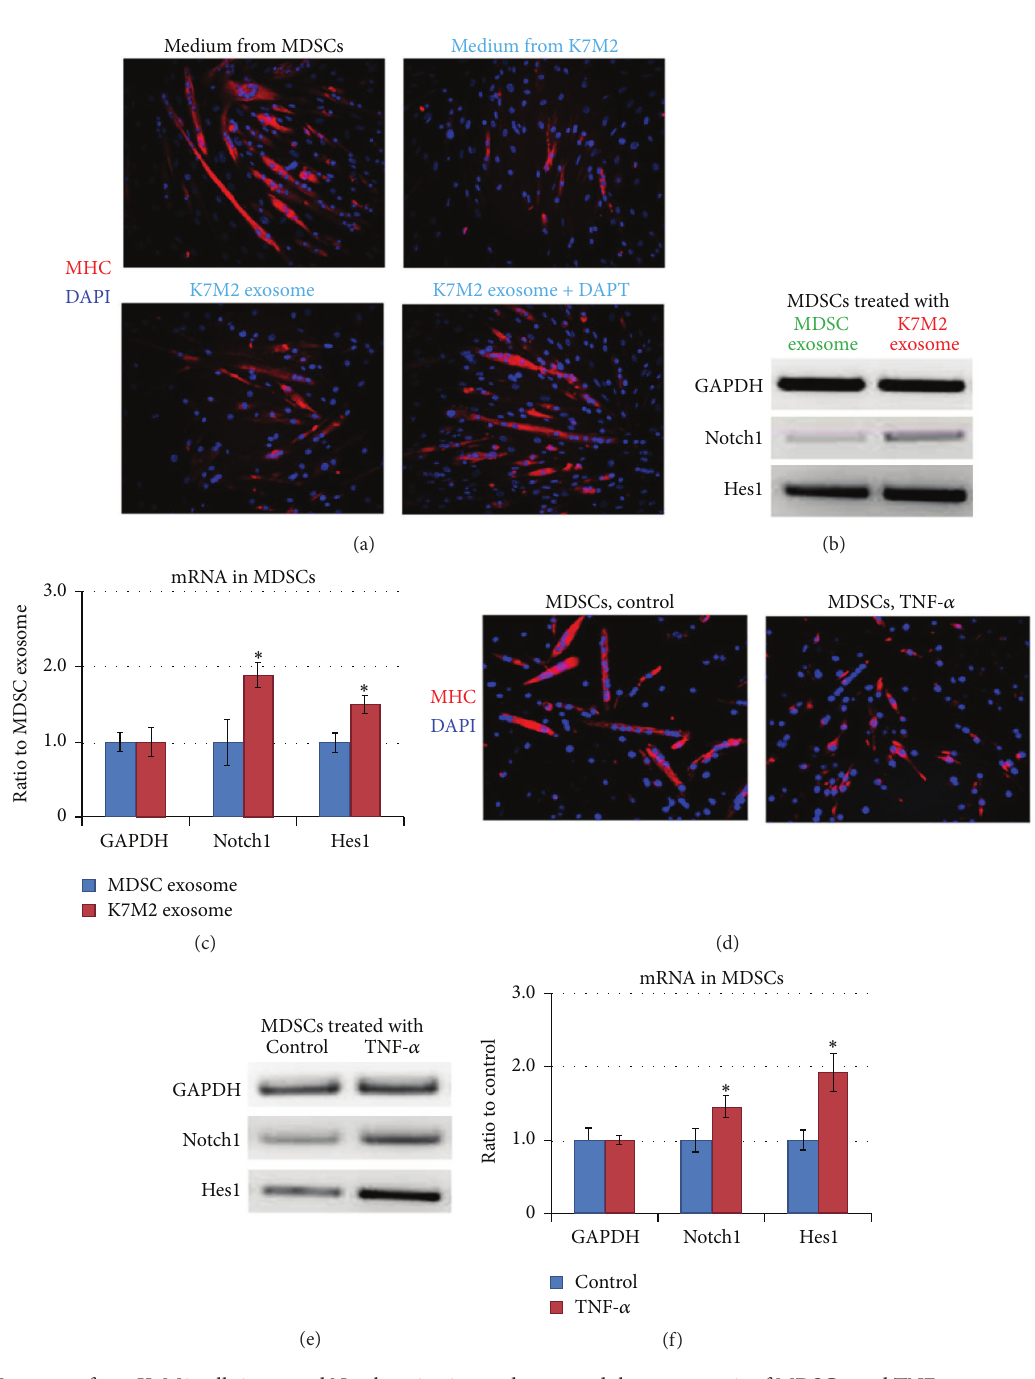
Figure 6: Exosomes from K7M2 cells increased Notch activation and repressed the myogenesis of MDSCs, and TNF- 𝛼 treatment of MDSCs repressed myogenesis by activating Notch signaling. (a) MDSCs were treated with culture medium of MDSCs, culture medium of K7M2 cells, exosomes isolated from the culture medium of K7M2 cells (K7M2 exosomes), and K7M2 exosomes plus DAPT. Myotube formation was measured with immunostaining against MHC. (b) The expression of Notch1 and Hes1 in MDSCs treated with K7M2 exosomes or MDSC exosomes was compared with semiquantitative PCR. (c) Differential expression of Notch1 and Hes1 in MDSCs/K7M2 exosome versus MDSCs/MDSC exosome. (d) Myogenesis of MDSCs with and without TNF- 𝛼 treatment was compared using immunostaining of MHC. (e) TNF- 𝛼 treatment (20 ng/mL) of MDSCs upregulated the expression of Notch1 and Hes1. (f) Differential expression of Notch1 and Hes1 in K7M2 with or without TNF- 𝛼 treatment. “ ∗ ” in the bar chart indicates 𝑃 < 0.05